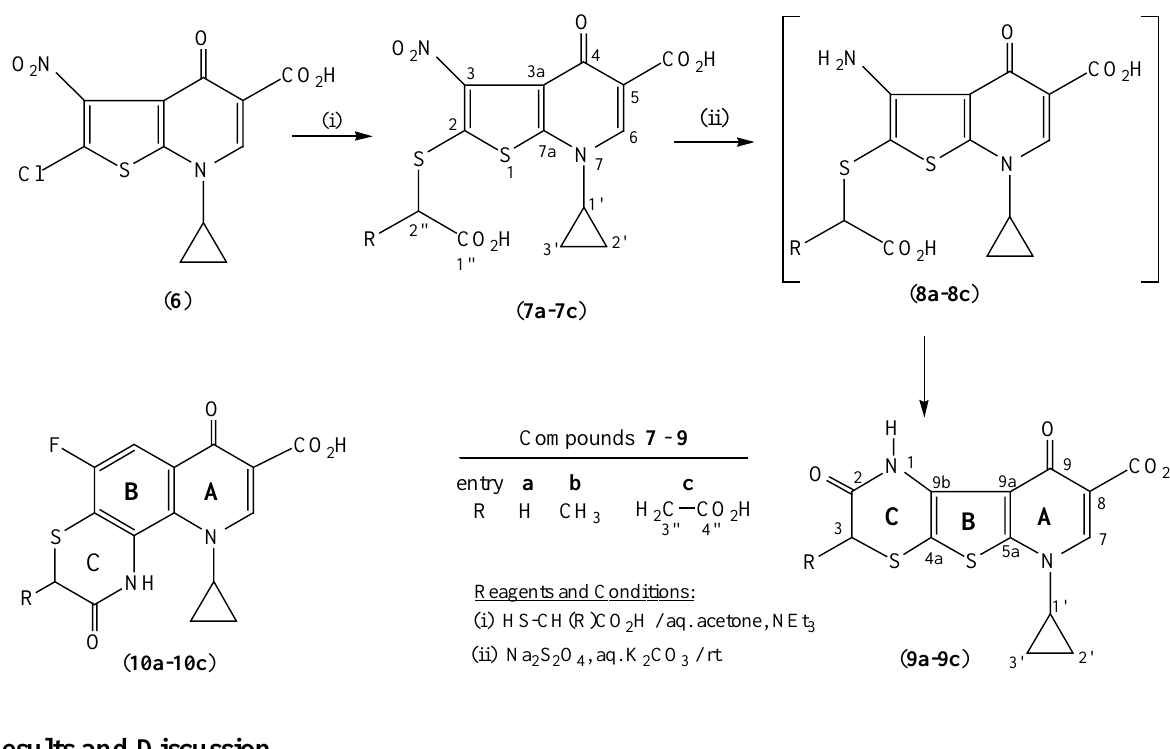
Scheme 1. Synthesis of pyrido[3', 2': 4, 5]thieno[2,3- b ][1,4]thiazines 9a - 9c